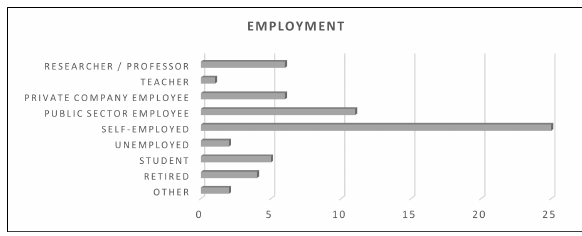
Figure 3: Frequency distribution of employment.